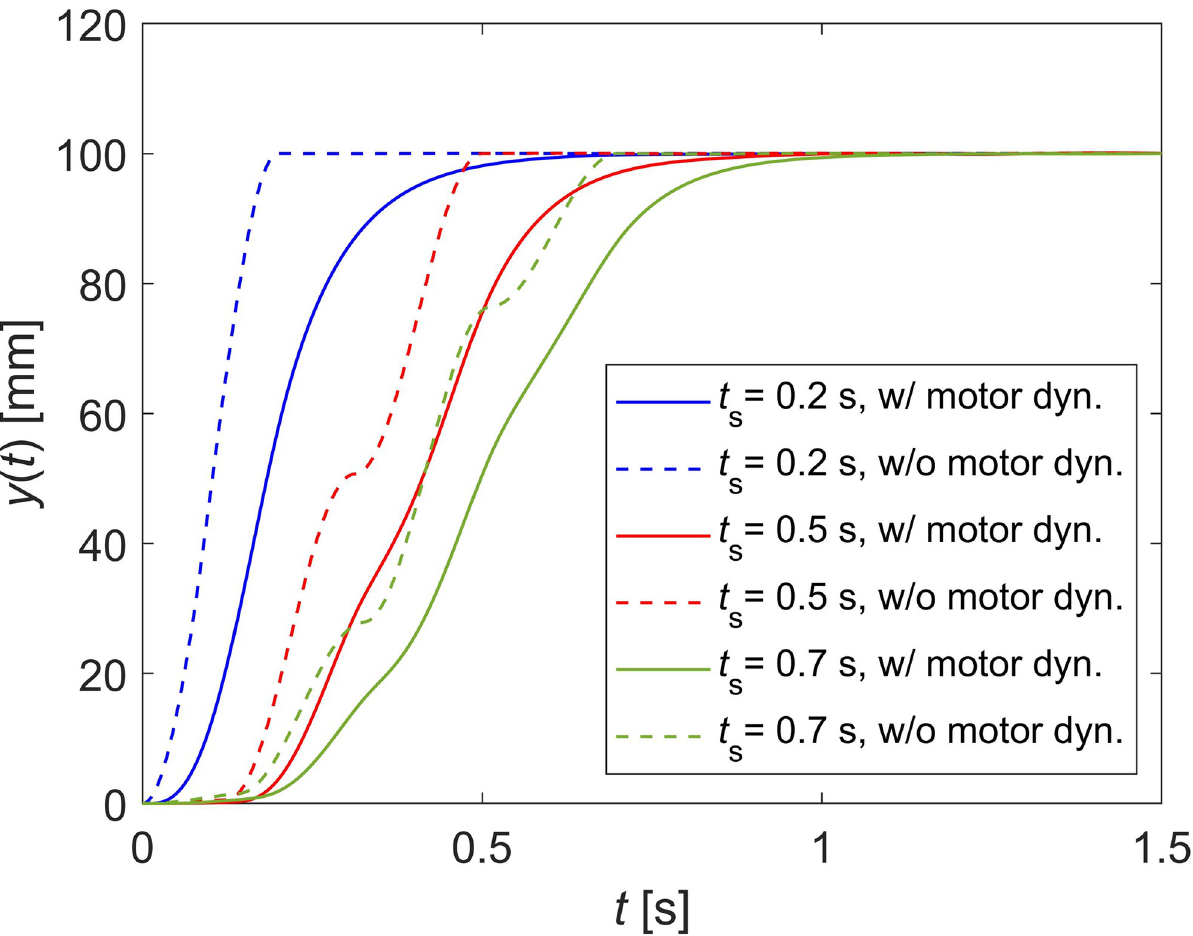
Fig 12. Simulation results for three SD shapers with and without motor feedback dynamics.